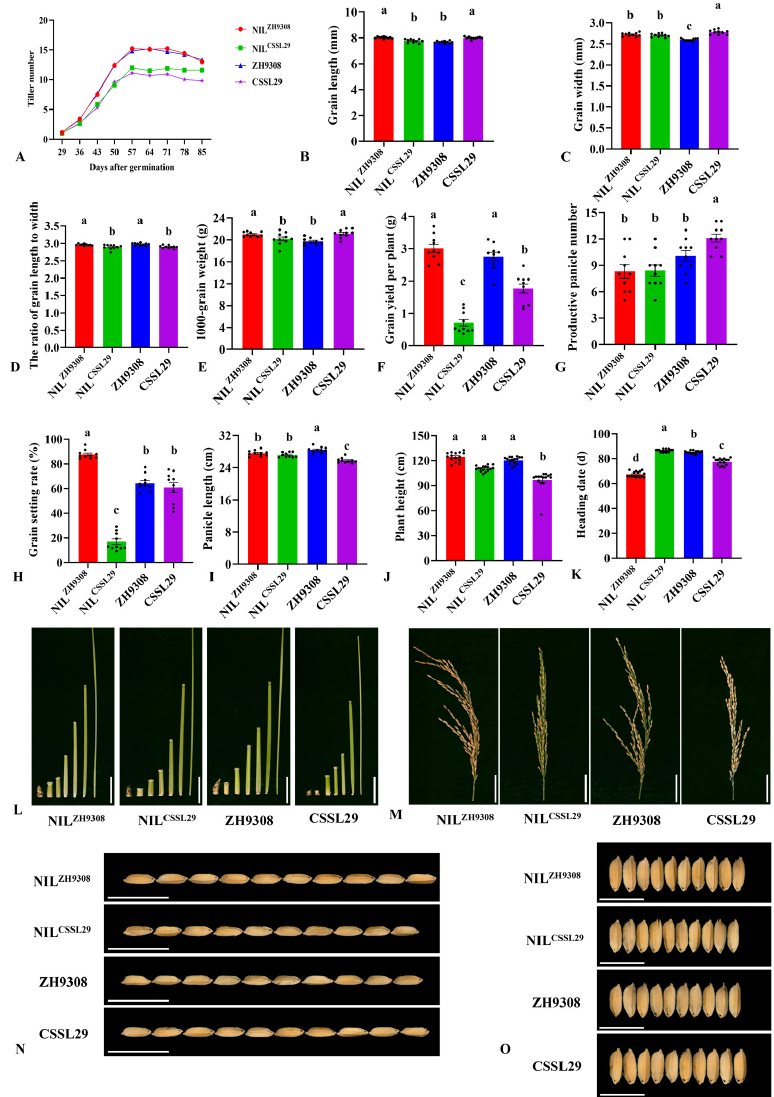
Figure 7. Agronomic trait comparison between NIL ZH9308 , NIL CSSL29 , ZH9308 and CSSL29 in 2022, Fuyang: ( A ) the dynamic tiller number of the NIL ZH9308 , NIL CSSL29 , ZH9308 and CSSL29; and ( B – O ) agronomic trait comparison between NIL ZH9308 , NIL CSSL29 , ZH9308 and CSSL29. Data shown represent means ± SEM. n = 30 in ( A ); n = 10 in ( B – I ); n = 16 in ( J – K ). Different letters indicate significant differences between lines according to Duncan’n test ( p < 0.05). Scale bar is 10 cm in ( L – M ), 1 cm in ( N – O ).